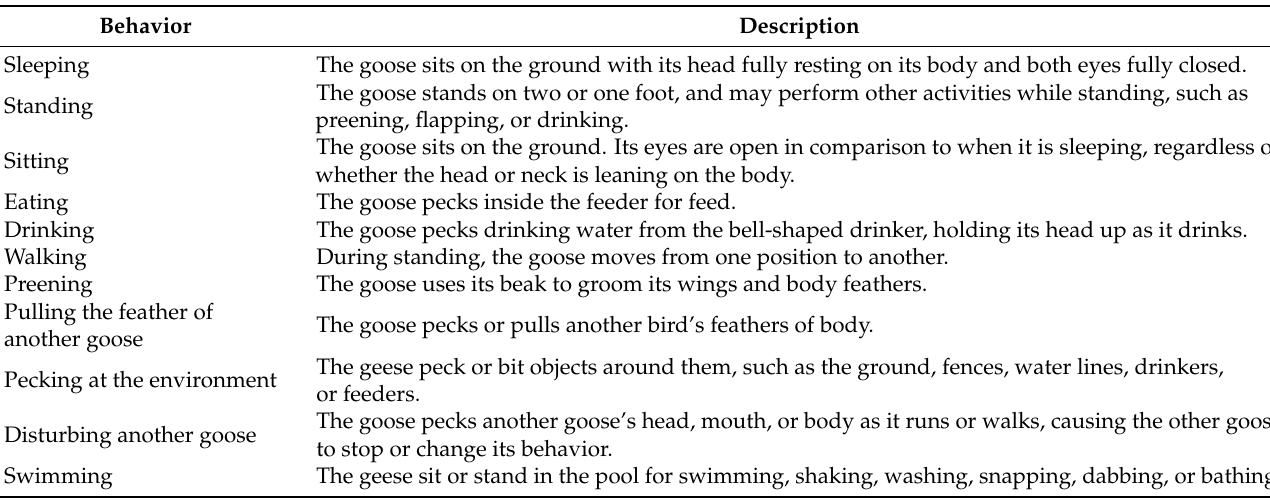
Table 2. Ethogram of recorded behaviors of